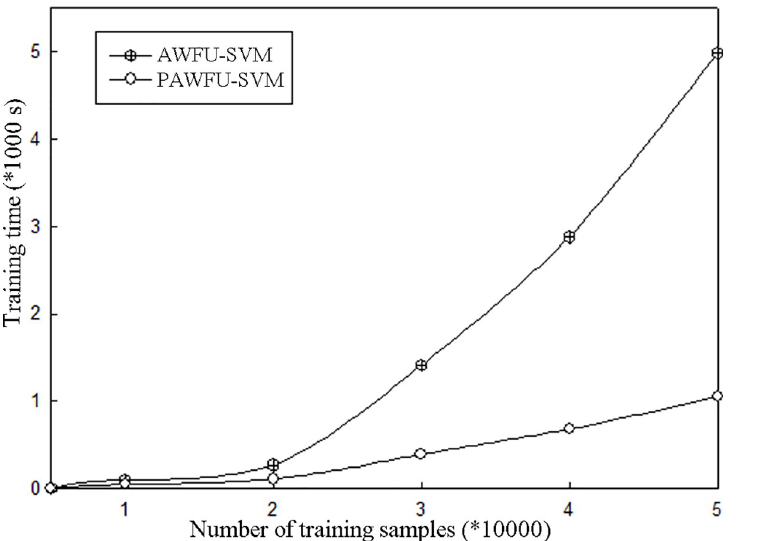
Fig 7. Comparison of the training times among different